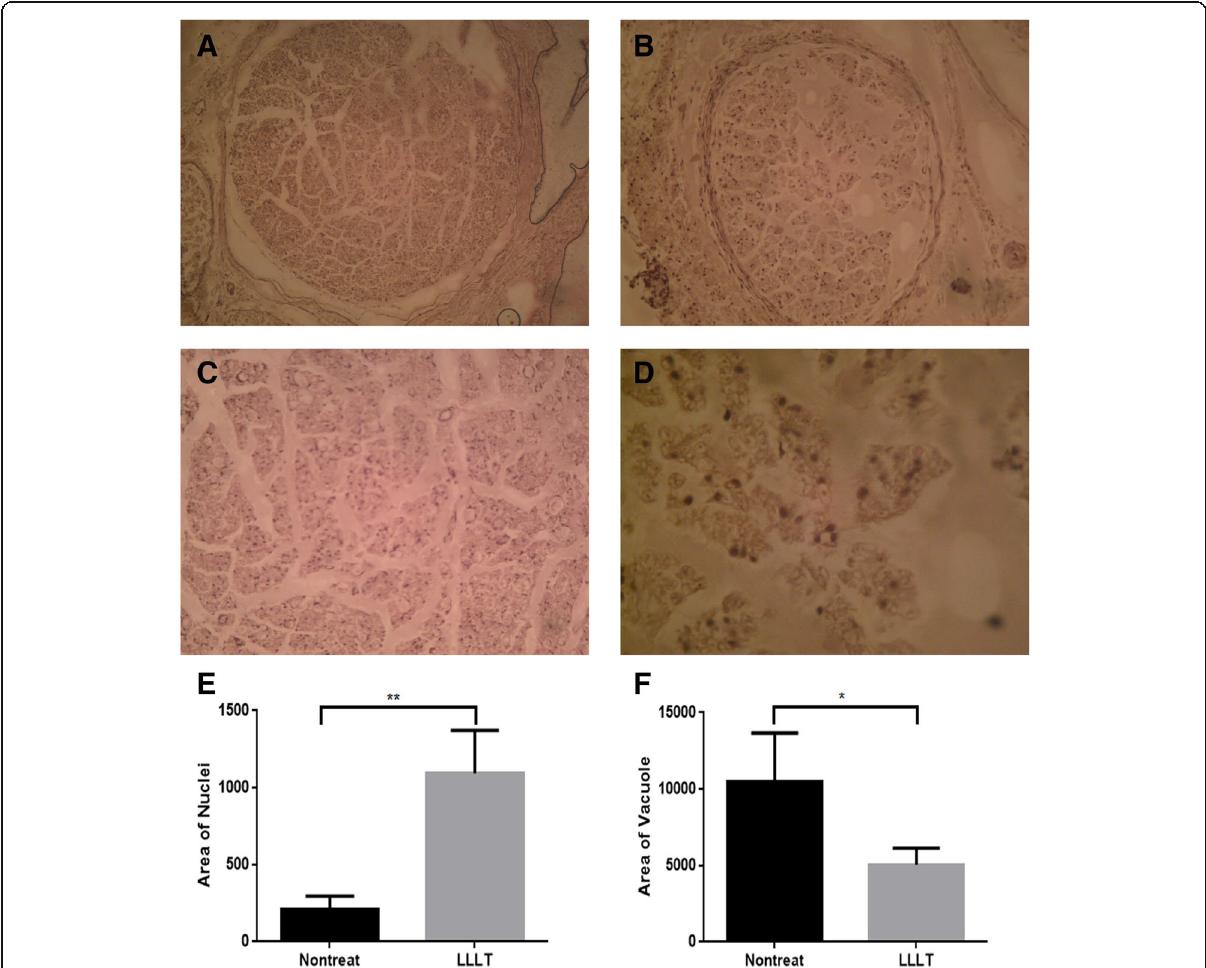
Fig. 4 Histological images of transected sciatic nerve after hematoxylin and eosin staining in the treatment (LLLT) group ( a and c ) and untreated group ( b and d ). a , b Lower magnified views of the LLLT and no treatment groups. The transverse sections showed Wallerian degeneration in the untreated group. While nerve fibers and Schwann cells numbers increased in the treated group. e and f Histopathological pictures quantitative analyses for nuclei and vacuole formation showing remarkable higher number of Schwann cells nuclei and lower number of vacuoles referring to healing for the treated nerve with significant changes between control and treated groups at a confidence level of p